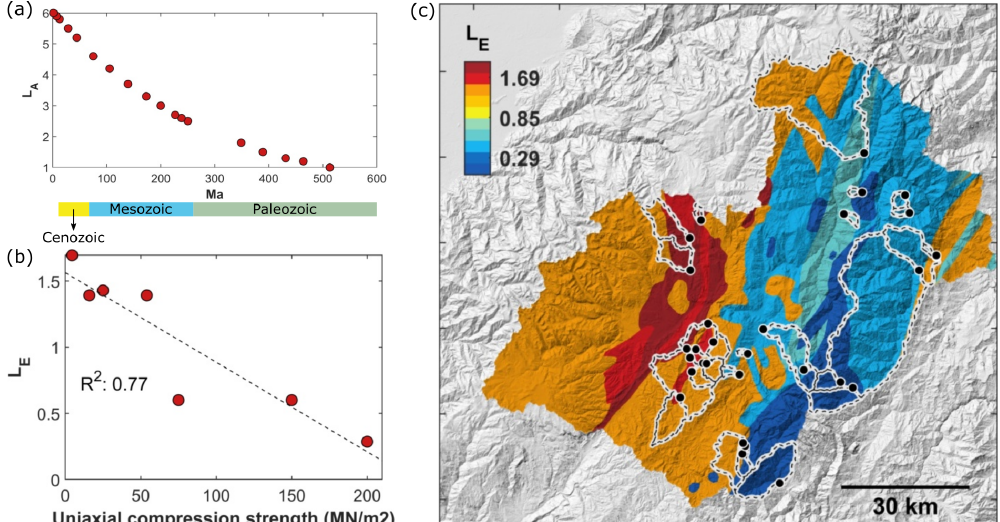
Figure 2. Development of empirical lithological erodibility index ( L E ) and its application to the Paute catchment. (a) Proposed lithological erodibility index based on lithological age ( L A ). Detailed sub-classifications per lithology can be found in Table S1. (b) Field measurements of uniaxial compressive strength (Basabe, 1998; Table S4) versus the empirical erodibility index calculated using Eq. (7). Note that two of the nine observations overlap on this plot. (c) Spatial distribution of L E in the Paute catchment. The underlying topographic map is based on the 30m SRTM v3 DEM (Farr et al., 2007). The lithological erodibility map for Ecuador was used to delineate different lithostratigraphic units and is based on the 1M geological map of Ecuador (Egüez et al., 2017; see also Fig. S1 in the Supplement). The map is produced with Topo Toolbox (Schwanghart and Scherler,